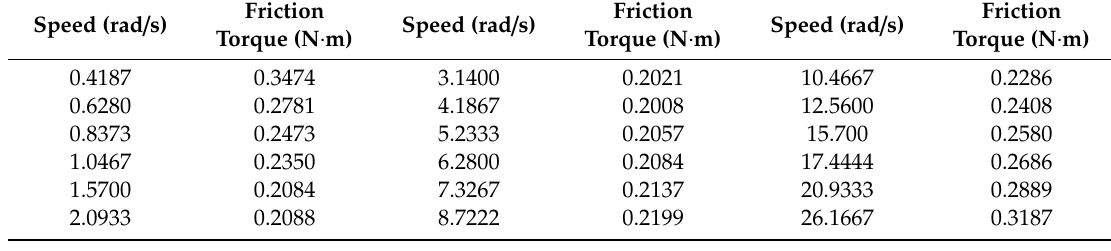
Figure 5. Friction torque of a RV reducer (2.0933 rad/s).